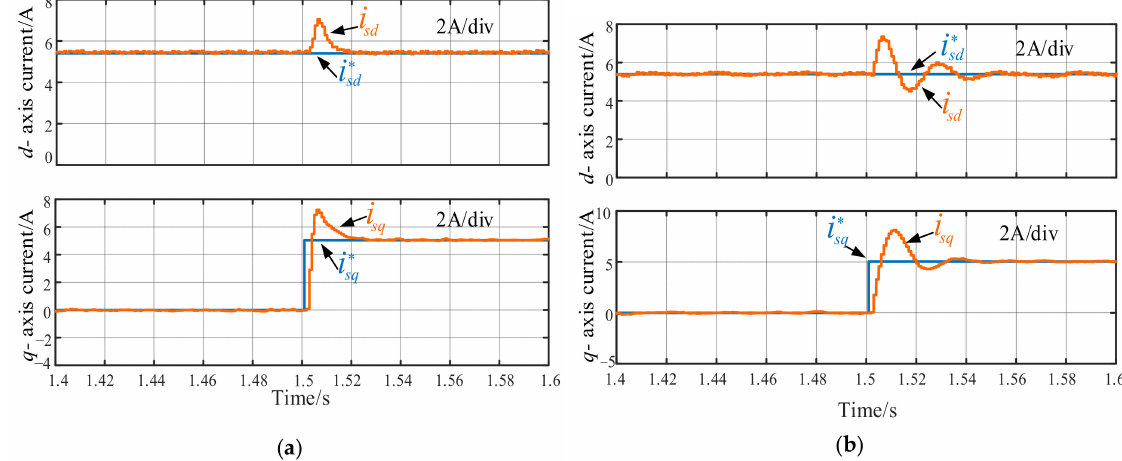
Figure 22. Step response of currents: ( a ) Feed-forward PI controller; ( b ) Feed-back PI